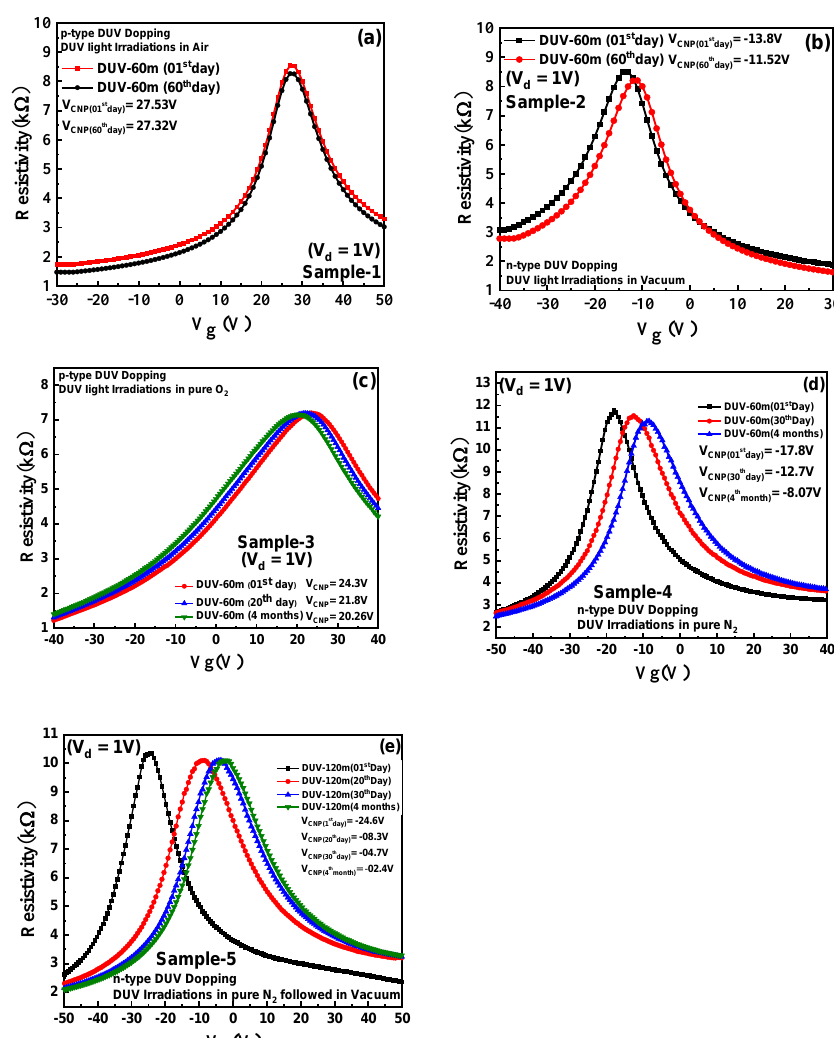
Figure 5. Doping stability: ( a ) Resistivity as a function of V g for sample-1 (DUV in air) for both the 1st and 60th day, exhibiting stable p-doping, confirmed with no shift in CNP. ( b ) Resistivity as a function of V g for n-type doped sample-2 (DUV in vacuum) for both the 1st and 60th day, showing a small de-doping of around 14% over the period. ( c ) Resistivity as a function of V g for sample-3 (DUV in pure O 2 ) for the 1st day to 4 months, exhibiting stable p-doping with a minor shift in CNP position. ( d ) Resistivity as a function of Vg for sample-4 (DUV in pure N 2 ) for 1st day to 4 months, exhibiting unstable n-doping with large de-doping. ( e ) Resistivity as a function of V g for sample-5 (DUV in pure N 2 environment followed by DUV in vacuum) for 1st day to 4 months, exhibiting unstable n-doping with a large de-doping effect confirmed by a shift in CNP towards a pristine condition.